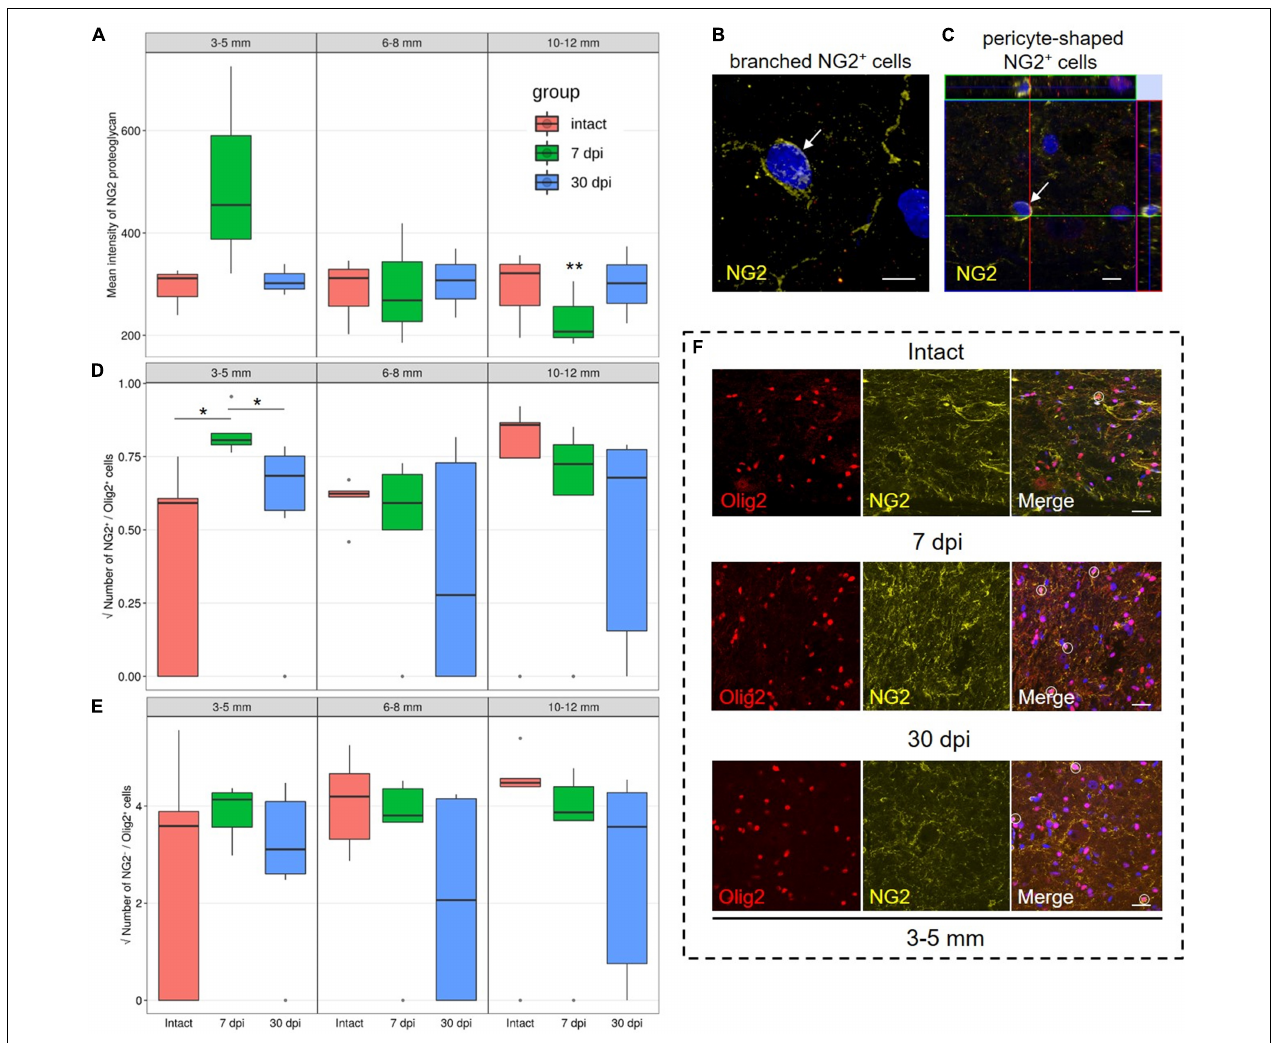
FIGURE 1 | Assessment of NG2 expressing cells and NG2 − /Olig2 + cells identification. (A) The mean intensity of NG2 (MIF units, Y -axis) in the intact spinal cord (red column), 7 (green column), and 30 (blue column) dpi in the ventral horns (VH) 3–5, 6–8, and 10–12 mm caudally from the injury epicenter. ** P < 0.05 – compared with 7 dpi group and distance of 3–5 mm from the epicenter. Visualization of the branched-shaped (B) and pericyte-shaped (C) NG2 + cells (arrows). Three-dimensional confocal microscopy images are shown. Nuclei were counterstained with 4 (cid:48) ,6-diamidino-2-phenylindole (DAPI). The square root of NG2 + /Olig2 + (D) and NG2 − /Olig2 + (E) cells number in the examined regions, * P < 0.05. (F) Visualization of the NG2 − /Olig2 + (red channel) and NG2 + /Olig2 + cells (merge channel, circle) in intact spinal cord, 7 and 30 dpi in VH, 3–5 mm caudally from the injury epicenter. Scale bar = 5 (B,C) and 20 (F) µ